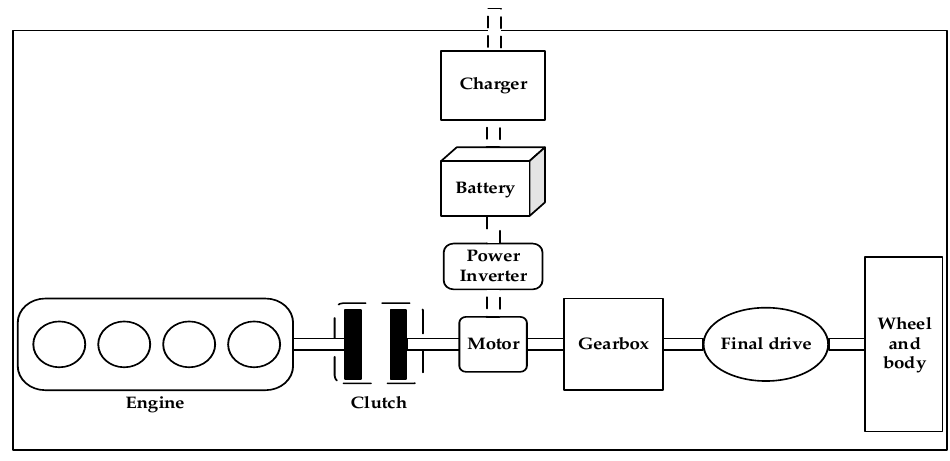
Figure 1. Structure of plug-in single-axis parallel hybrid power system.